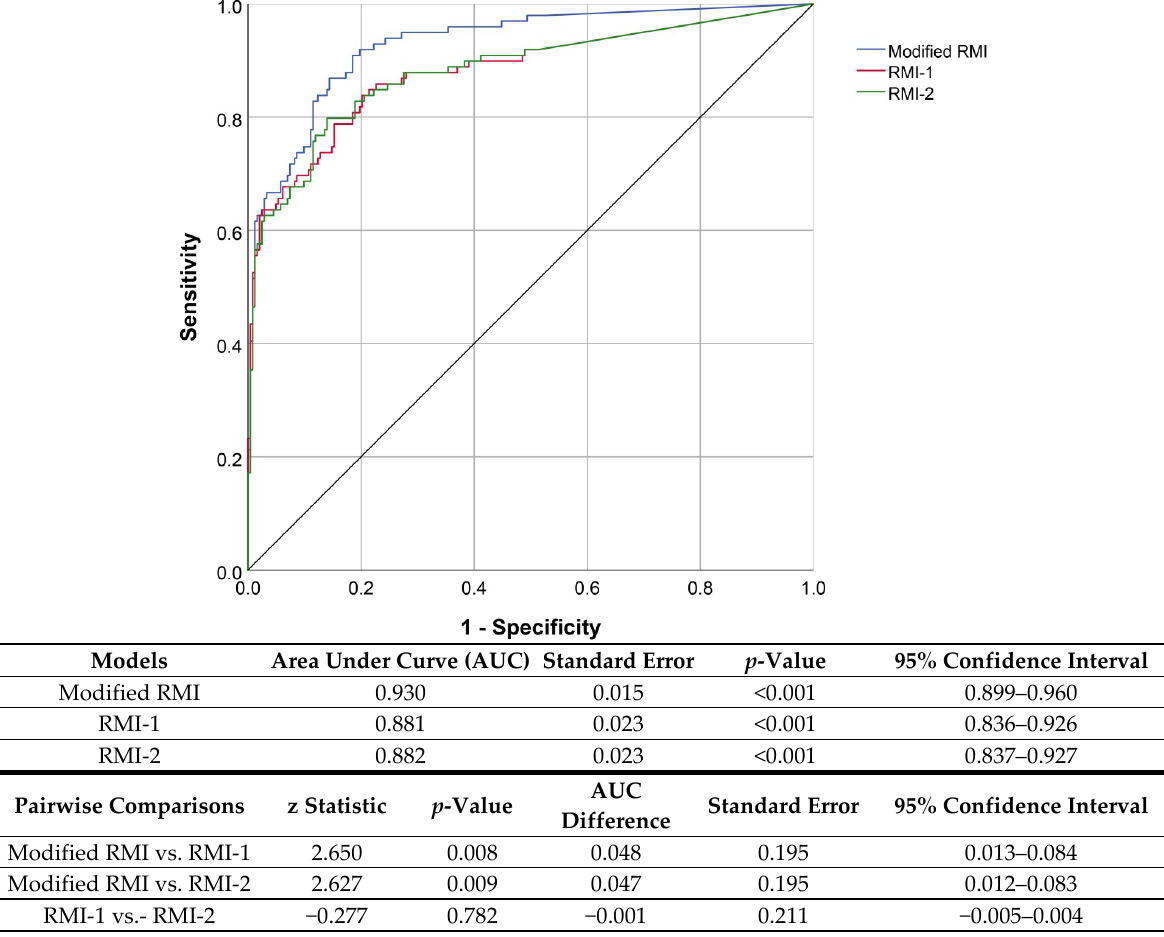
Figure 3. Receiver operating characteristic (ROC) curves present diagnostic performance of the three systems of risk of malignancy index (RMI) in predicting ovarian malignancy, together with the tables of AUC comparisons among the three systems (area under the curve; AUC: 0.930, 0.881 and 0.882 for modified RMI, RMI-1 and RMI2, respectively).